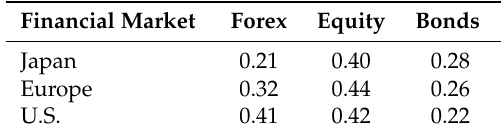
Table 2. Memory estimates for foreign exchange, equity and bond